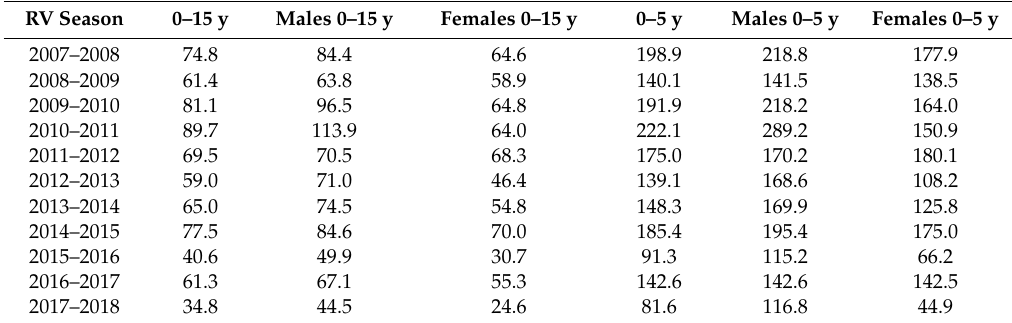
Table 1. Hospitalization rate (including one-day care) for RVAGE per 100,000 inhabitants in the 0 to 15-year-old age